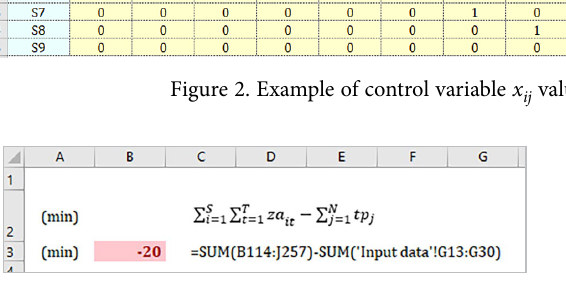
Figure 3. Spreadsheet implementation of the objective function